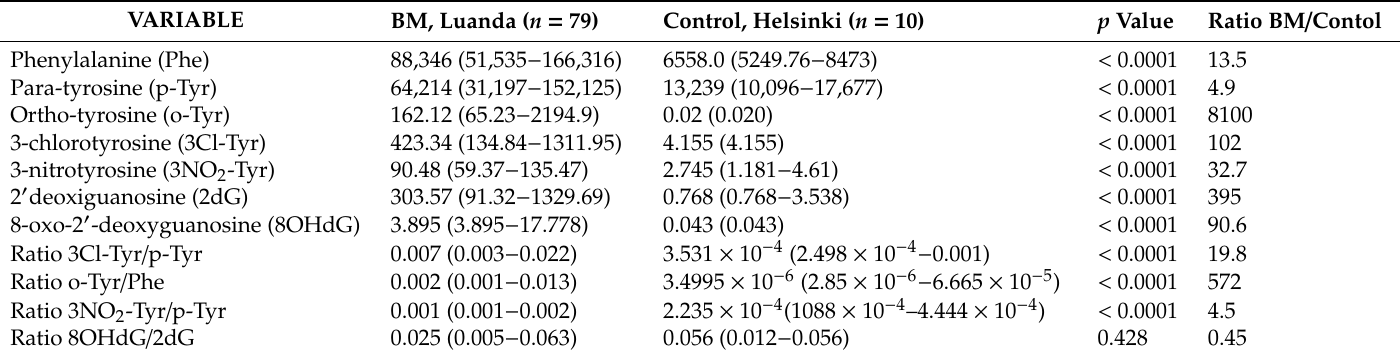
Table 3. Comparison of the admission median cerebrospinal fluid (CSF) concentrations (IQR) in nmol / L of biomarkers of ROS / RNS-mediated stress to proteins, DNA and inflammation between children with and without bacterial meningitis. Mann-Whitney U test.